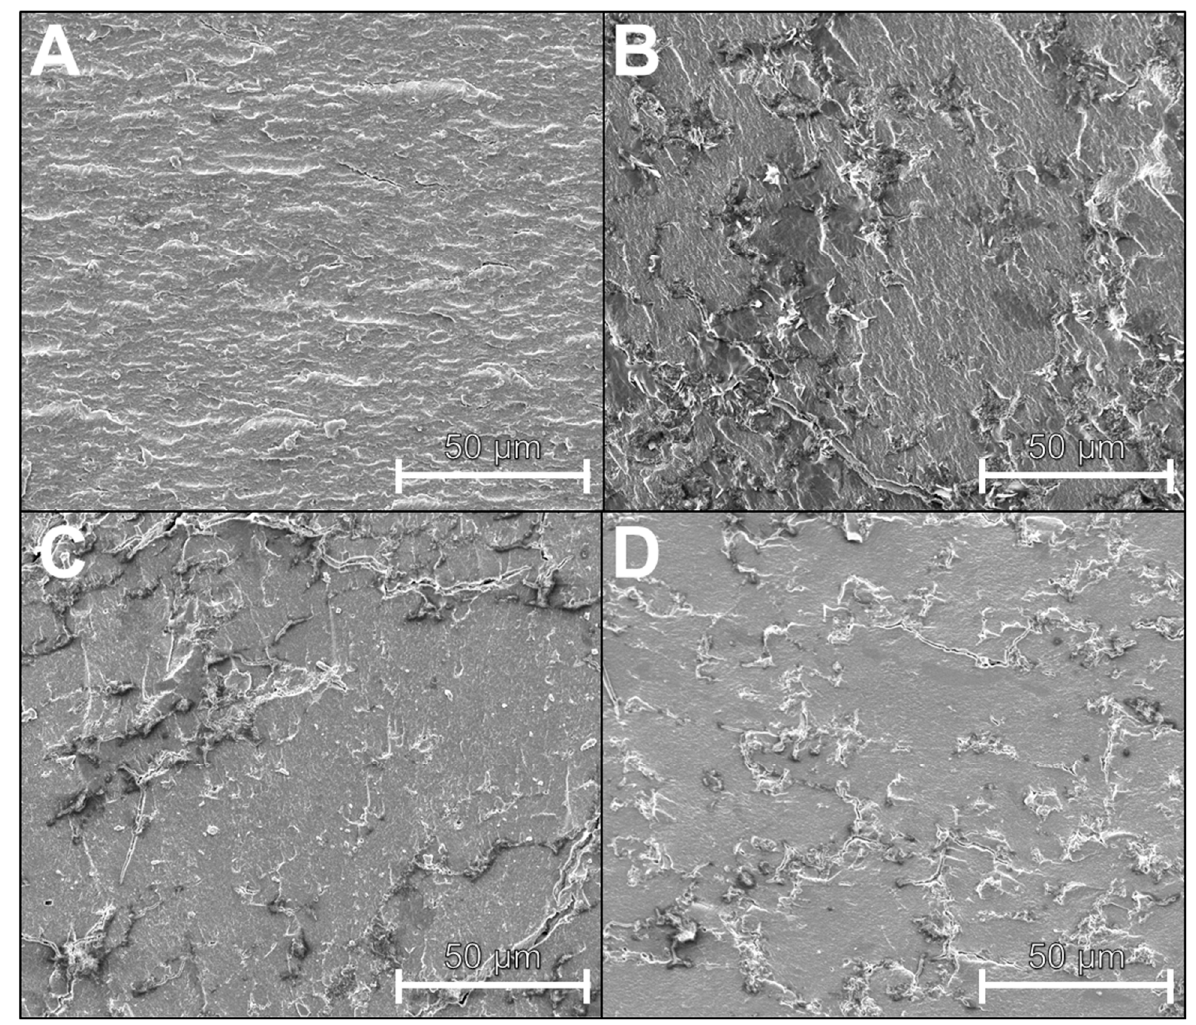
Figure 9. SEM-images of pellets, which underwent defined, extrusion-like thermomechanical treatment at 125 °C and different shear rates (0, 75, 150 s − 1 ) in the CCR. ( A ) SPI, 0 s − 1 ; ( B ) SPI + 30% WPC, 0 s − 1 ; ( C ) SPI + 30% WPC, 75 s − 1 ; ( D ) SPI + 30% WPC, 150 s − 1 .